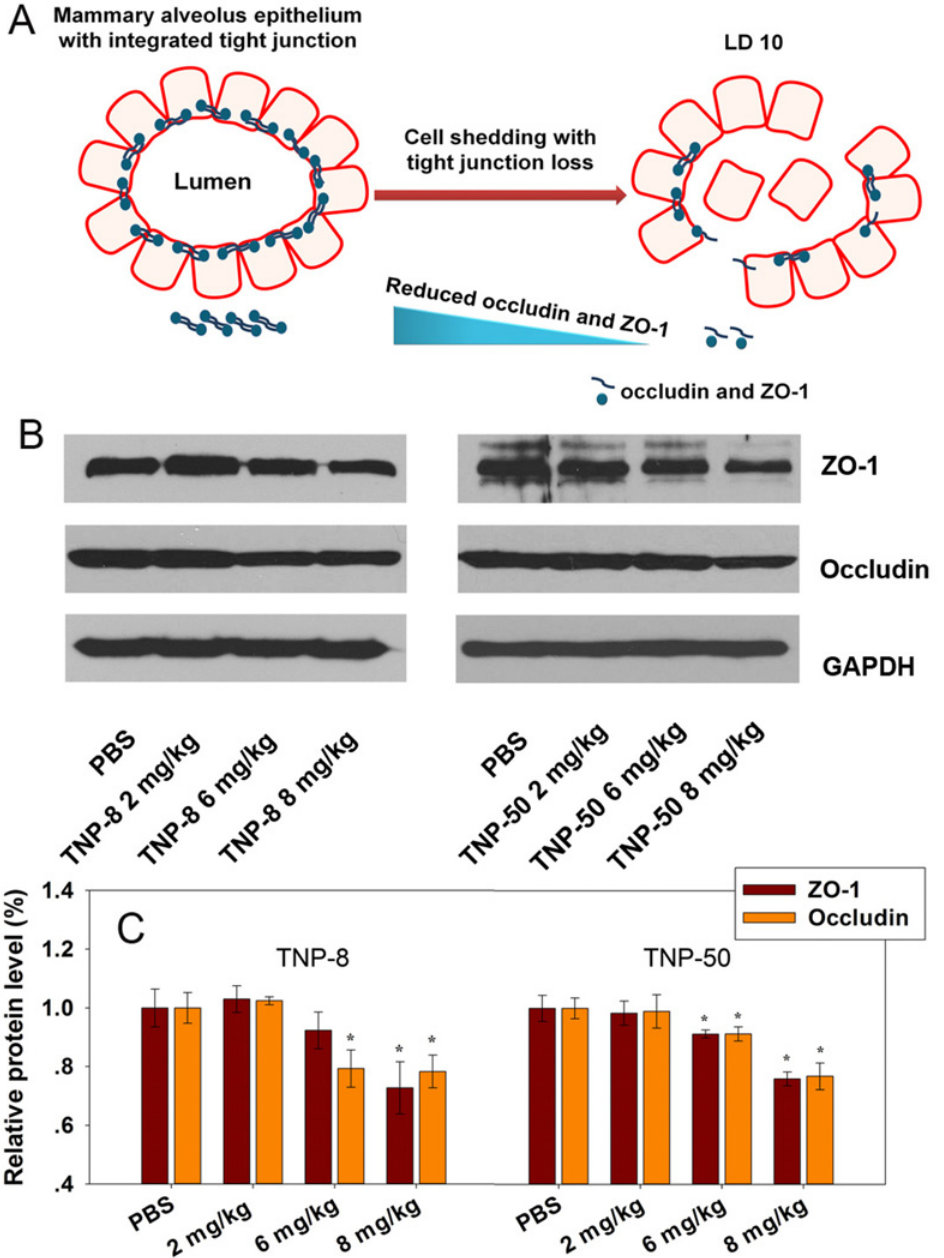
Fig 5. Effects of TNPs on mammary gland tight junction proteins ZO-1 and occludin after four doses of TNPs exposure (2, 6, 8 mg/kg) to dams at LDs 2, 4, 6 and 8. (A) A plausible mechanistic schematic showing TNPs made cell shedding and loose the tight junction between the mammary gland epithelial cells through oxidative stress. (B) Western blot of ZO-1 and occludin in mammary glands. (C) Bar graphs show relative levels of tight junction proteins ZO-1 and occludin by normalizing PBS group to 1.0. The symbol * represents significant difference from the PBS group (P < 0.05), (n = 3).